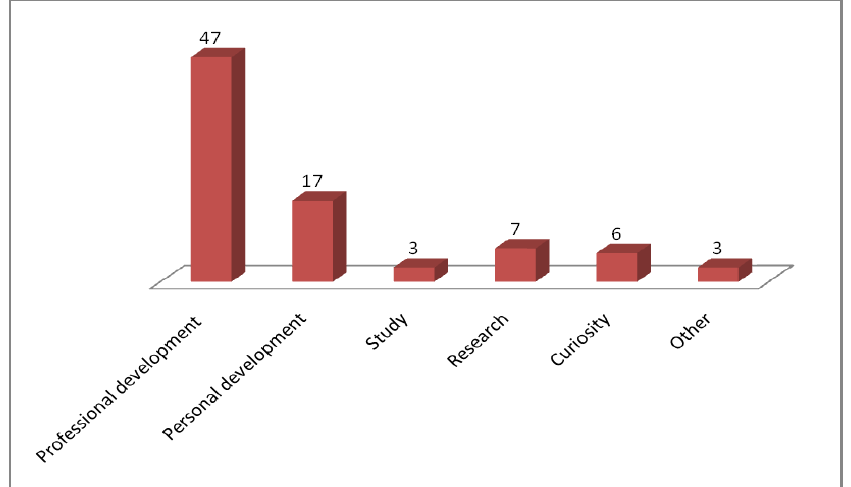
Figure 3 . Motivation for attending CCK08 course ( N =